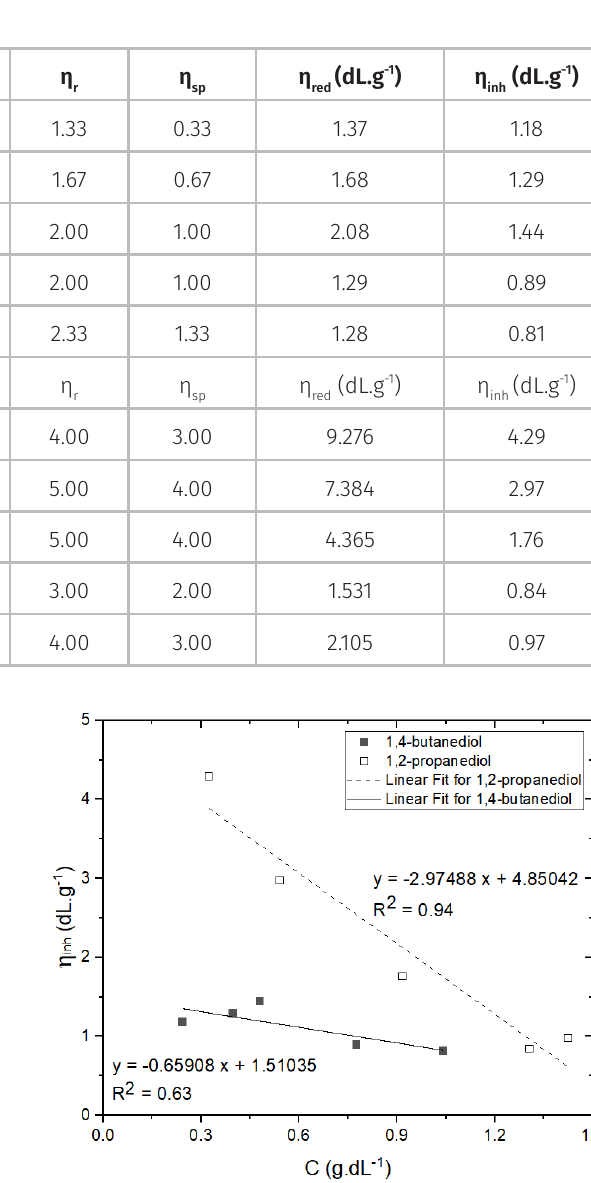
Figure 4. Data adjustment of Huggins equation for reduced viscosity versus concentration for diluted HTPB resin solutions in 1,4-butanediol and 1,2-propanediol.